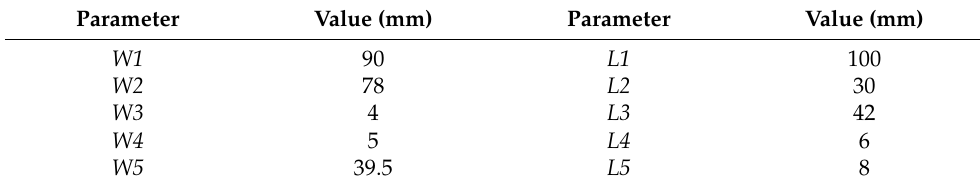
Figure 10. Transformation process of the patch dimensions. Table 9. Dual Band Antenna